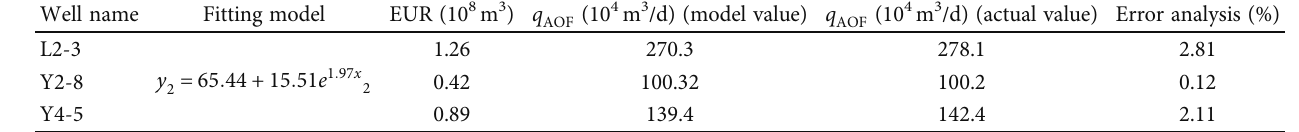
Table 8: Error analysis